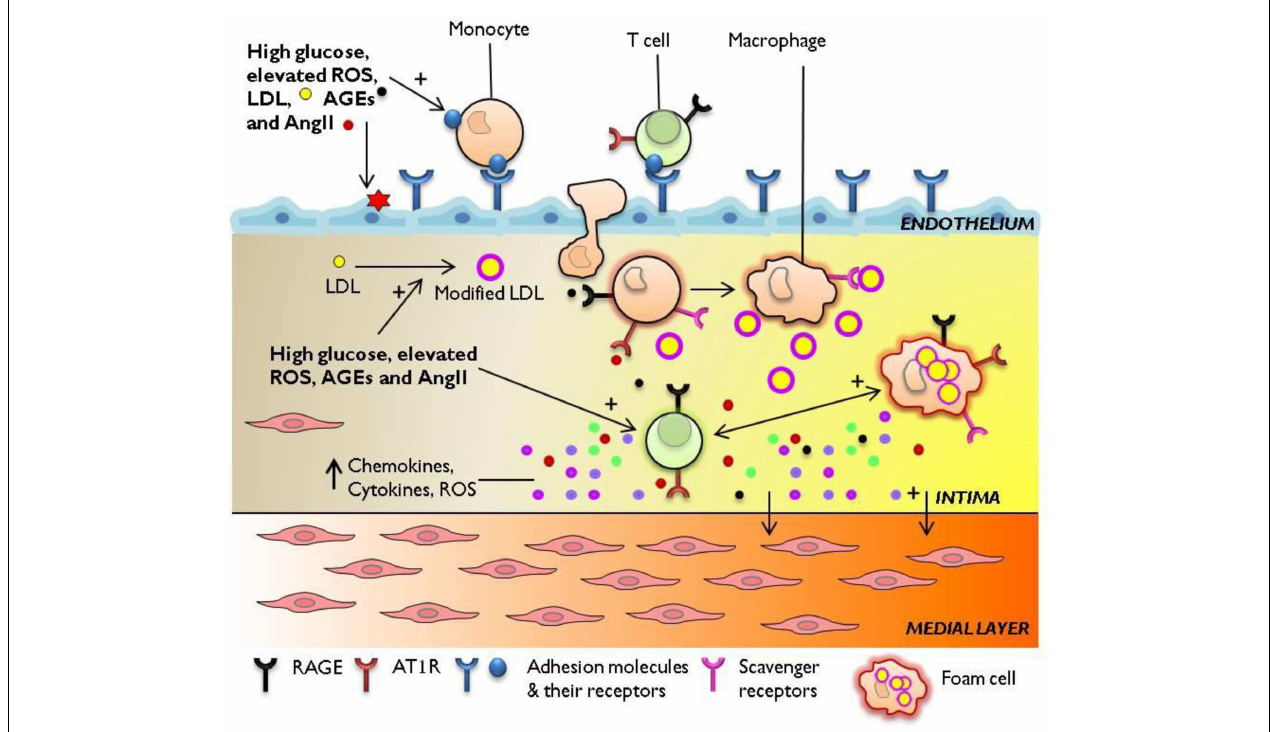
FIGURE 1 | Immune mechanisms engaged in diabetes-accelerated atherosclerosis . Diabetes-associated hyperglycemia, hyperlipidemia, and oxidative stress render the endothelium dysfunctional, leading to the retention and oxidation of LDL molecules in the intimal space.The increased expression of adhesion molecules E-selectin, ICAM-1,VCAM-1 at the endothelial membrane, and upregulation of chemotactic molecules such as MCP-1 facilitate the continuous infiltration of immune cells to the inflamed aorta. Resident and monocyte-derived macrophages engulf LDL to form foam cells which release a host of pro-inflammatory cytokines, protease, and